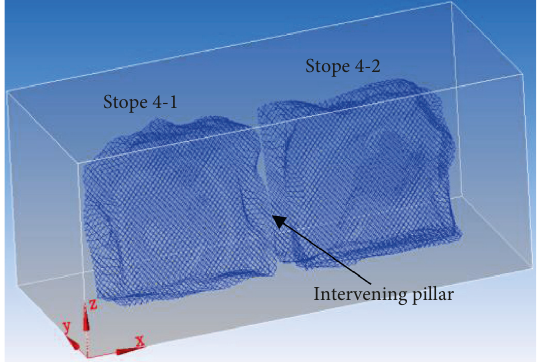
Figure 12: 3D scanning graphic of